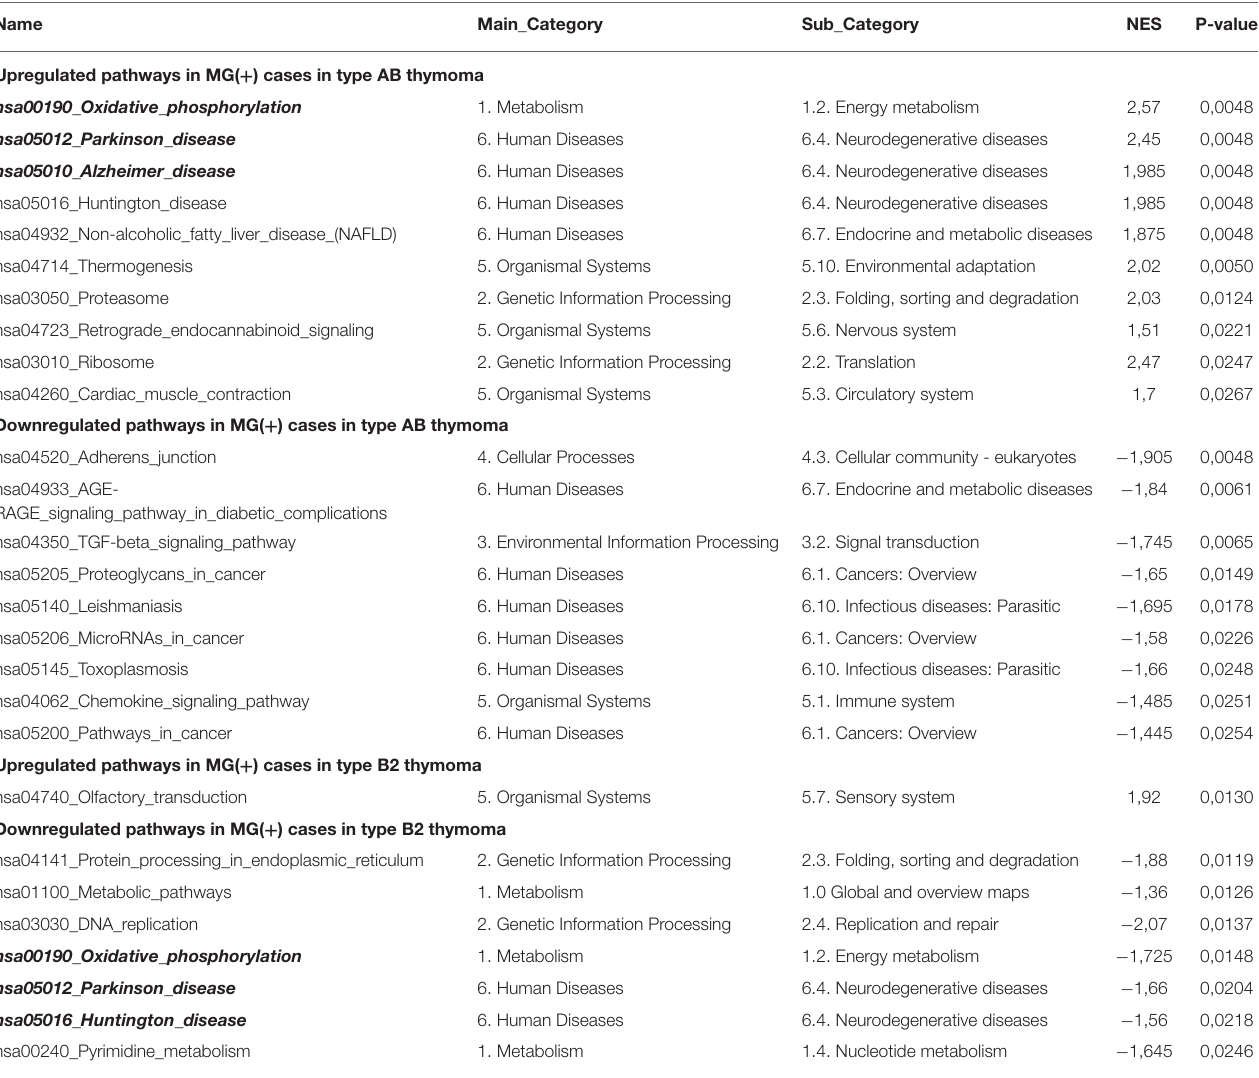
TABLE 1 | Upregulated or downregulated KEGG pathways in myasthenia gravis (MG).